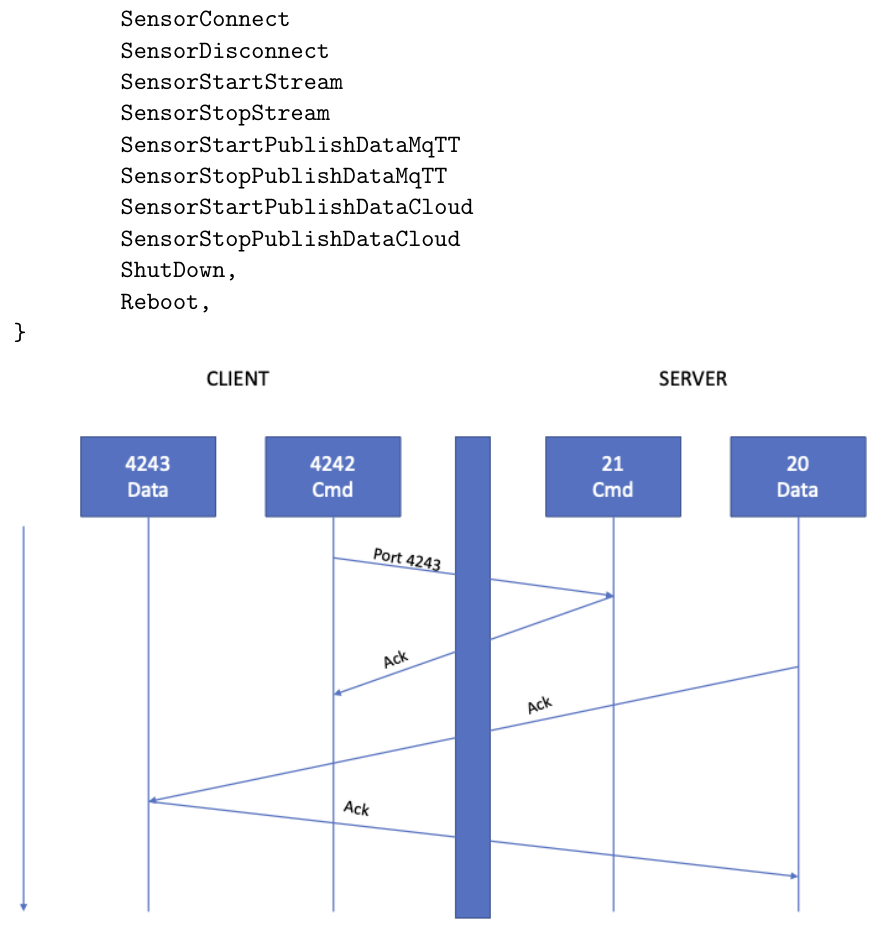
Figure 3. TCP/IP commands